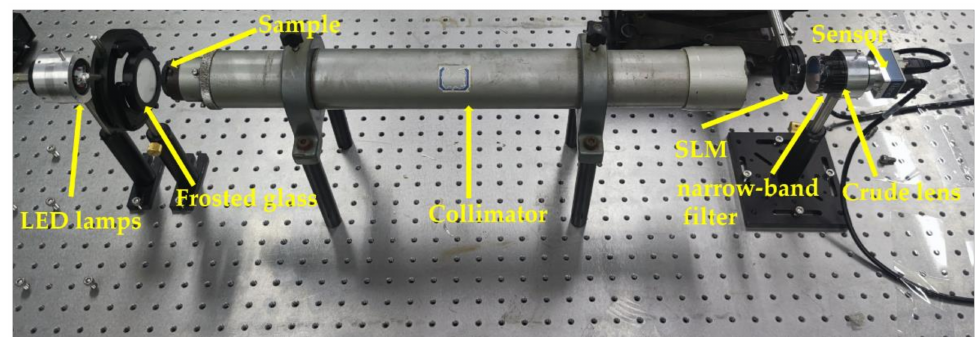
Figure 7. Experimental